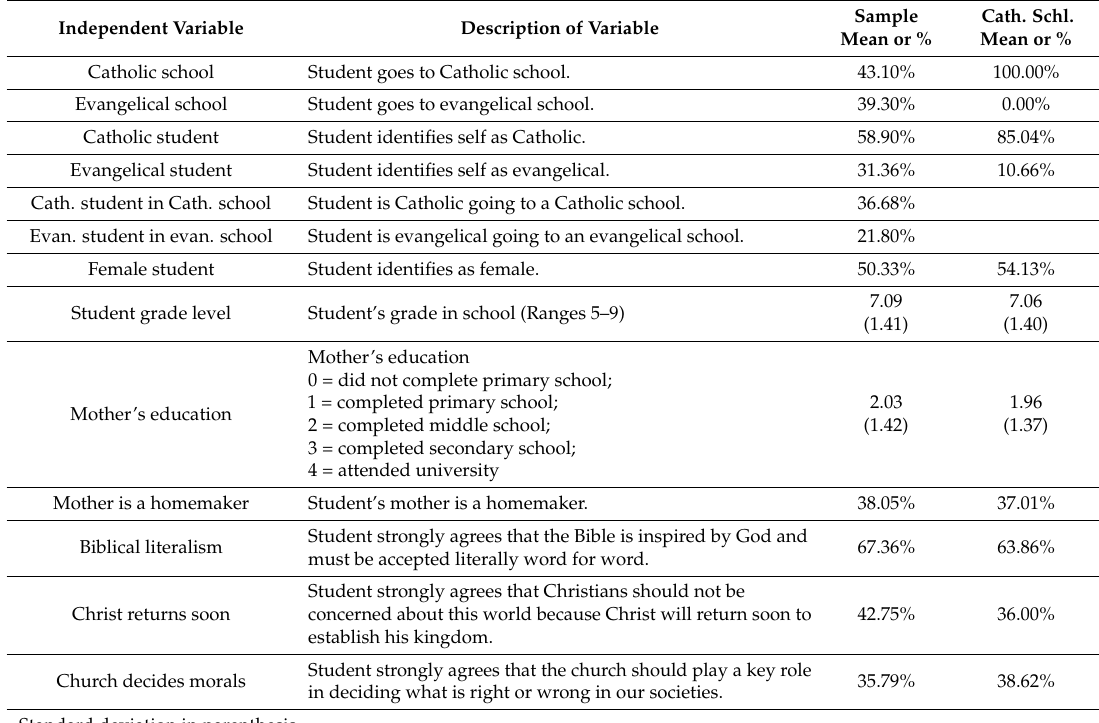
Table 5. Descriptive Statistics of Independent Variables in Gender Attitude